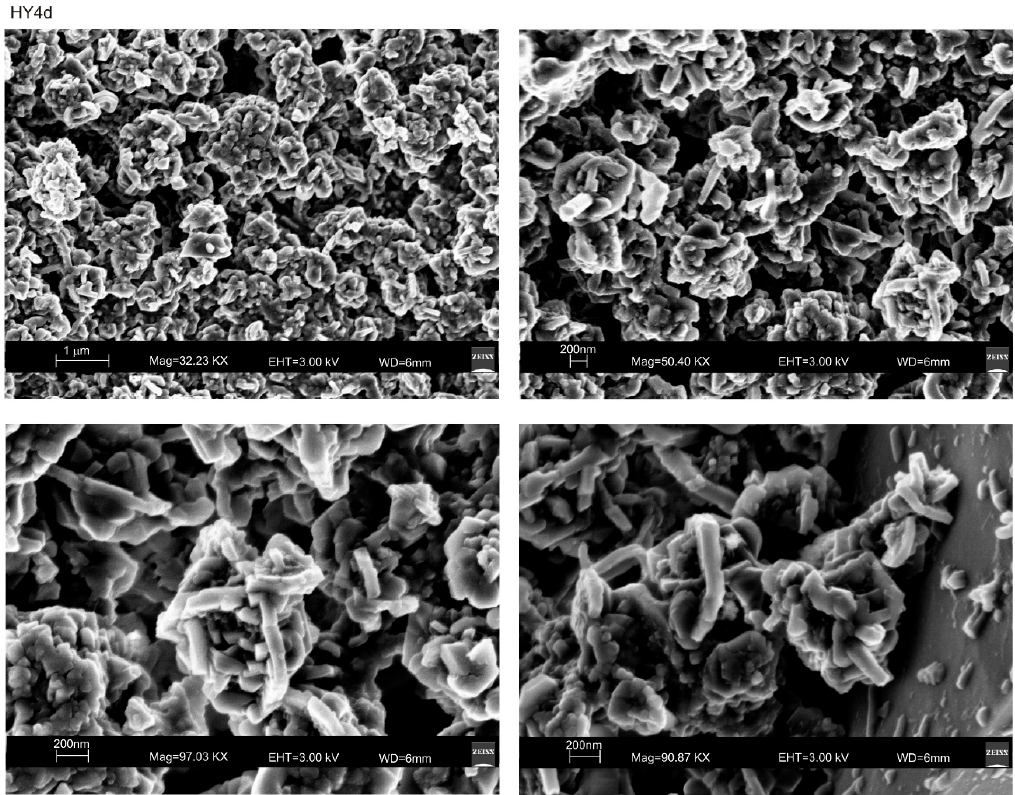
Figure 3. SEM images of EMT-type zeolite formed by 4-days conventional hydrothermal process